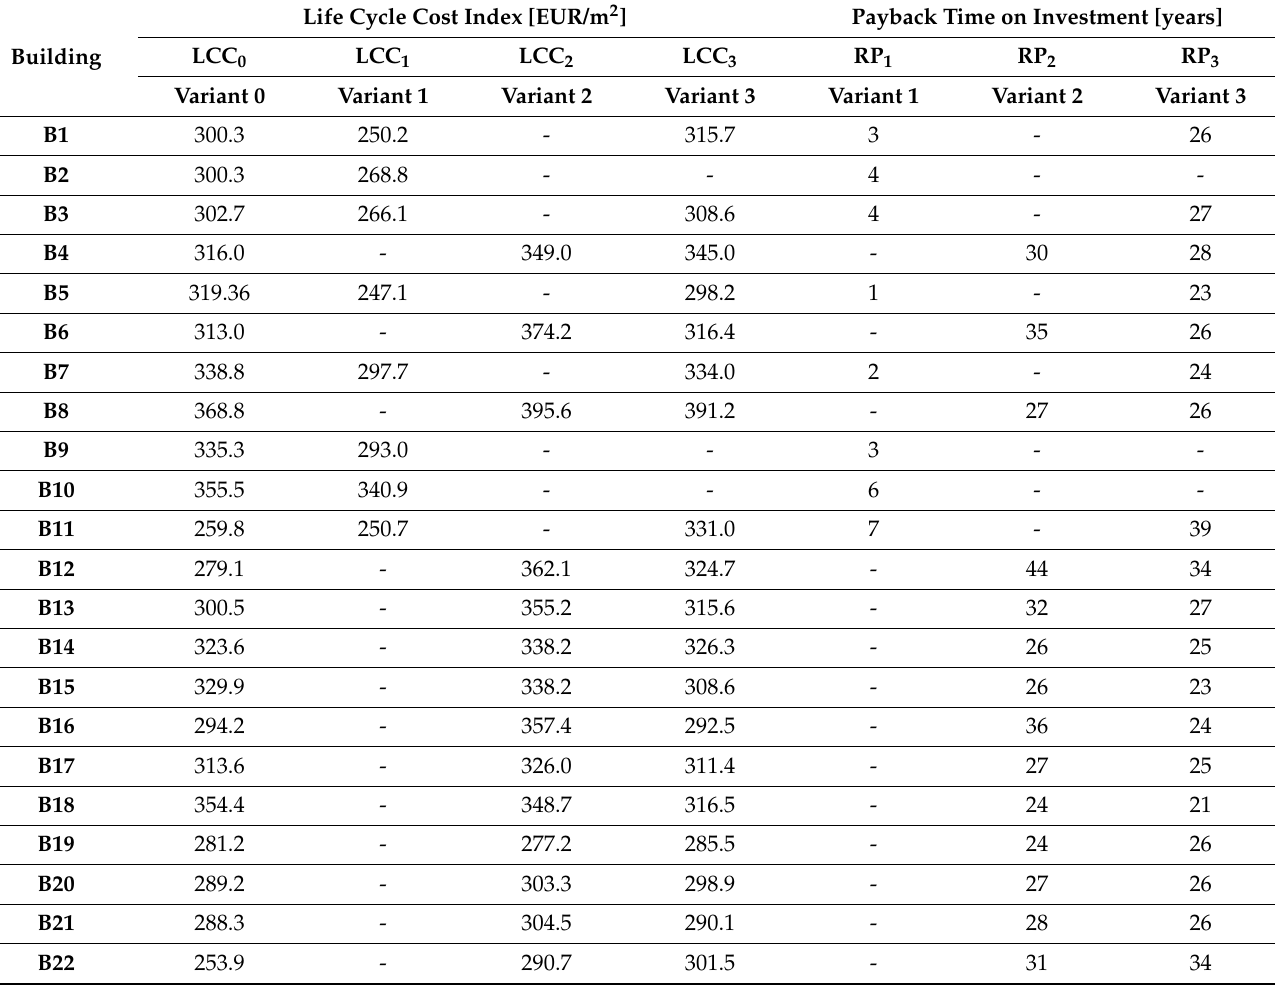
Table 15. Life cycle cost index before retrofit LCC 0 [EUR/m 2 ] and after retrofit projects LCC 1 –LCC